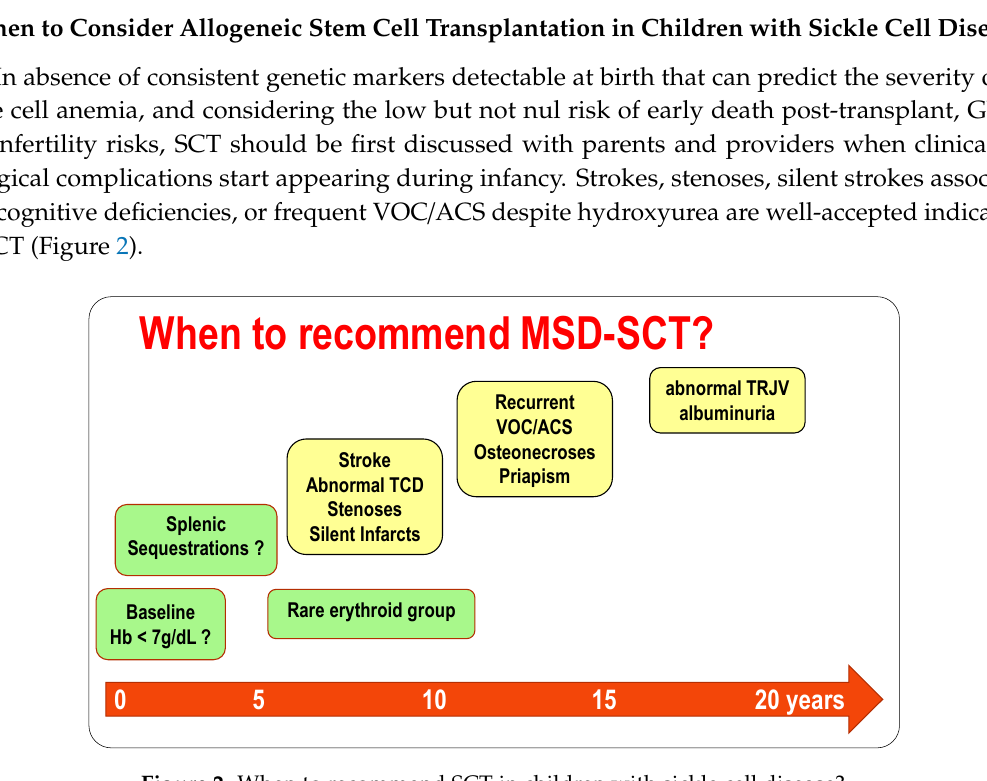
Figure 2. When to recommend SCT in children with sickle cell disease?